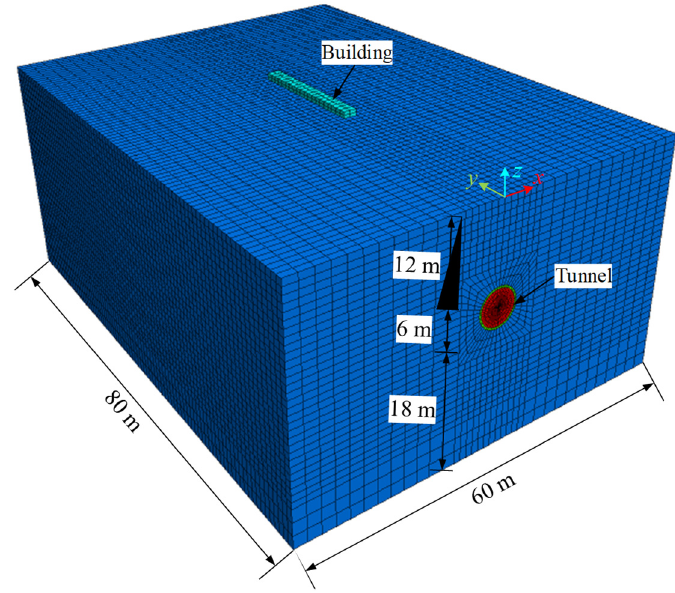
Figure 7. Finite difference model. Table 2. Physical and mechanical parameters of numerical model.